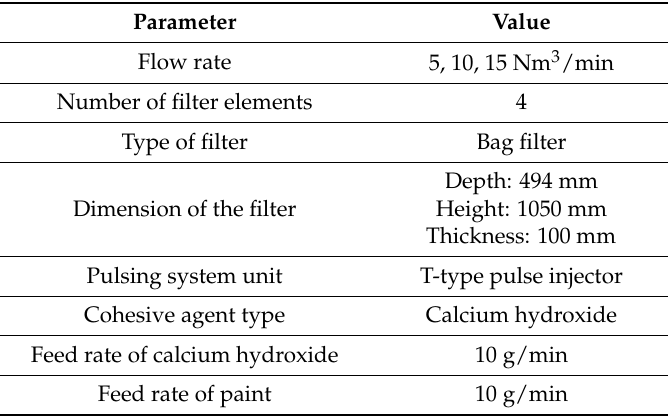
Figure 4. ( a ) Flow diagram and ( b ) scene of the actual laboratory. Table 3. Summaries of the experimental